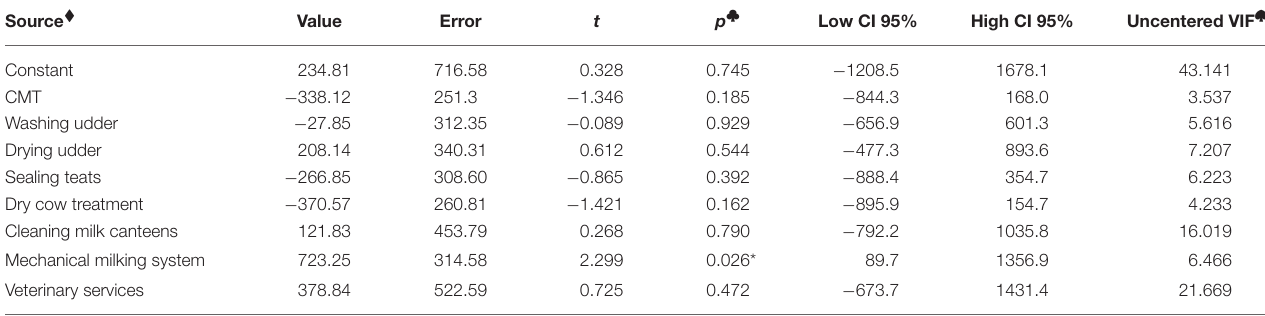
TABLE 8 | Regression ANOVA model of financial losses (adjusted to 10 cows/year) for preventive measures of mastitis (n: 55). Source (cid:7)